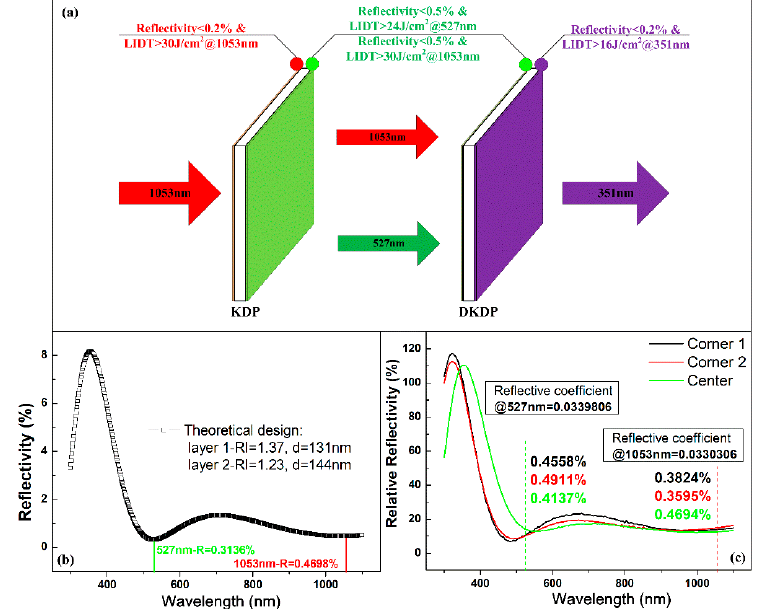
Figure 6. ( a ) Schematic diagram of coating system for nonlinear laser crystals in a high-power laser system, ( b ) spectrum of the theoretically designed coating system, ( c ) spectra of the practically prepared coating system.